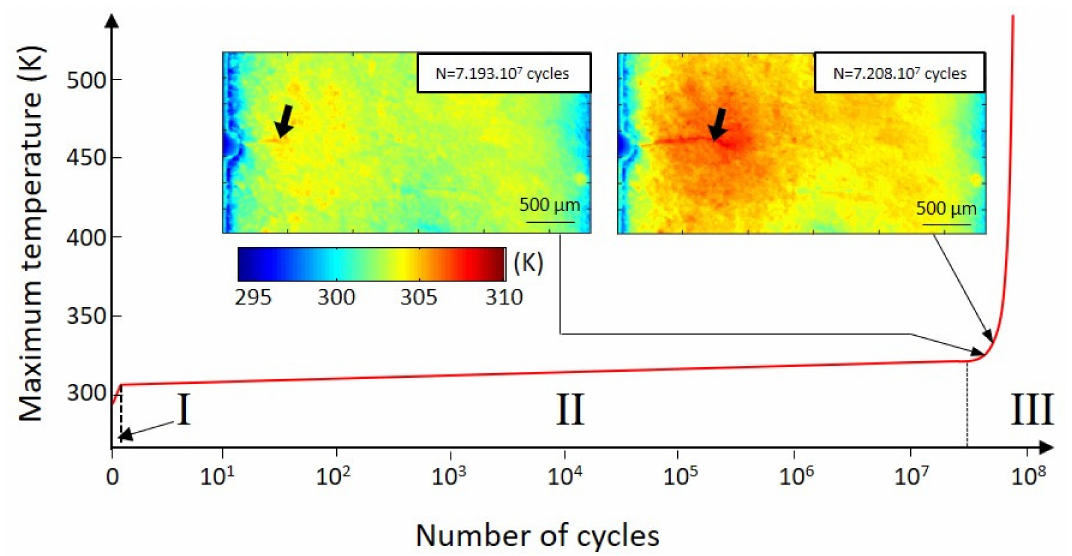
Figure 4. Distribution of temperature fields for various numbers of cycles (those pertinent to the crack tip are specified by the black arrows), and the evolution of the maximum temperature ( ◦ K) versus the number of cycles.